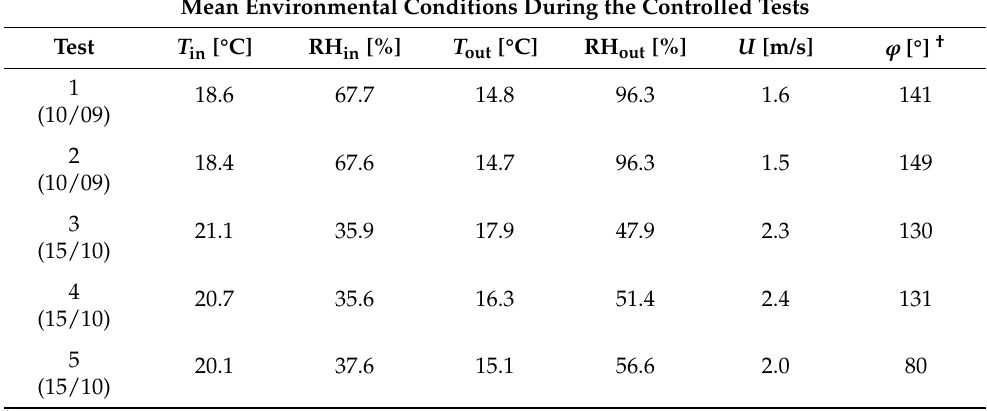
Table 3. Environmental conditions during controlled tests. Mean values were computed from the time series provided by AC1 and AC2 monitors (indoors) and by a nearby environmental